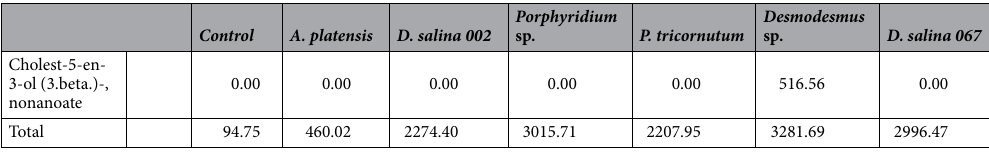
Table 2. Lipids profile of tomato plants leaves treated by microalgae